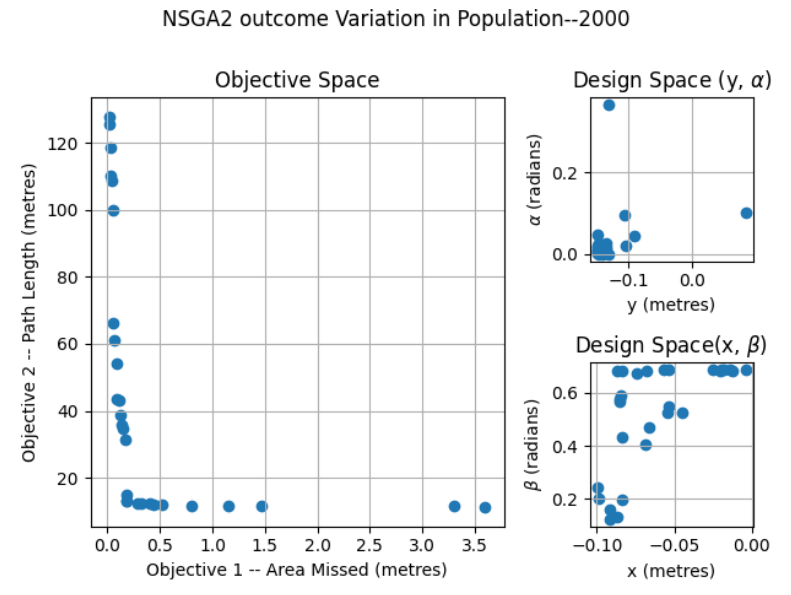
Figure 14. NSGA2 optimization for area size 4 × 2 m with population size = 2000.